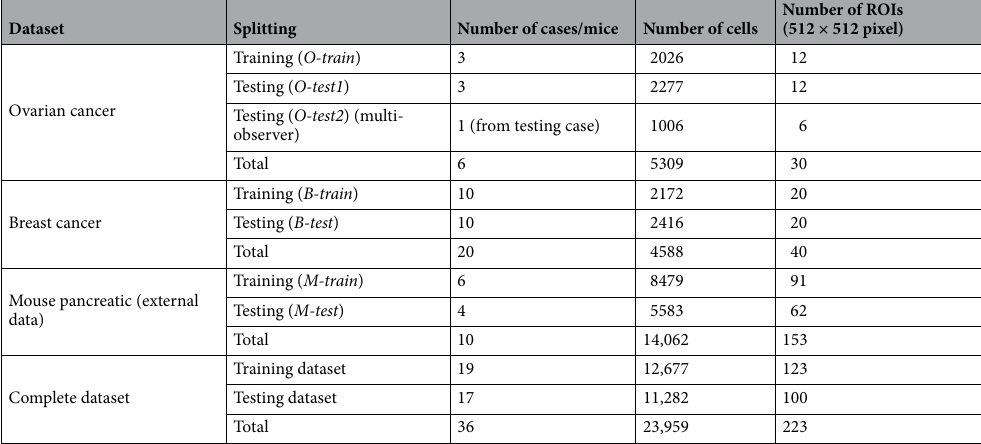
Table 1. Dataset information (the notation of each dataset is in the